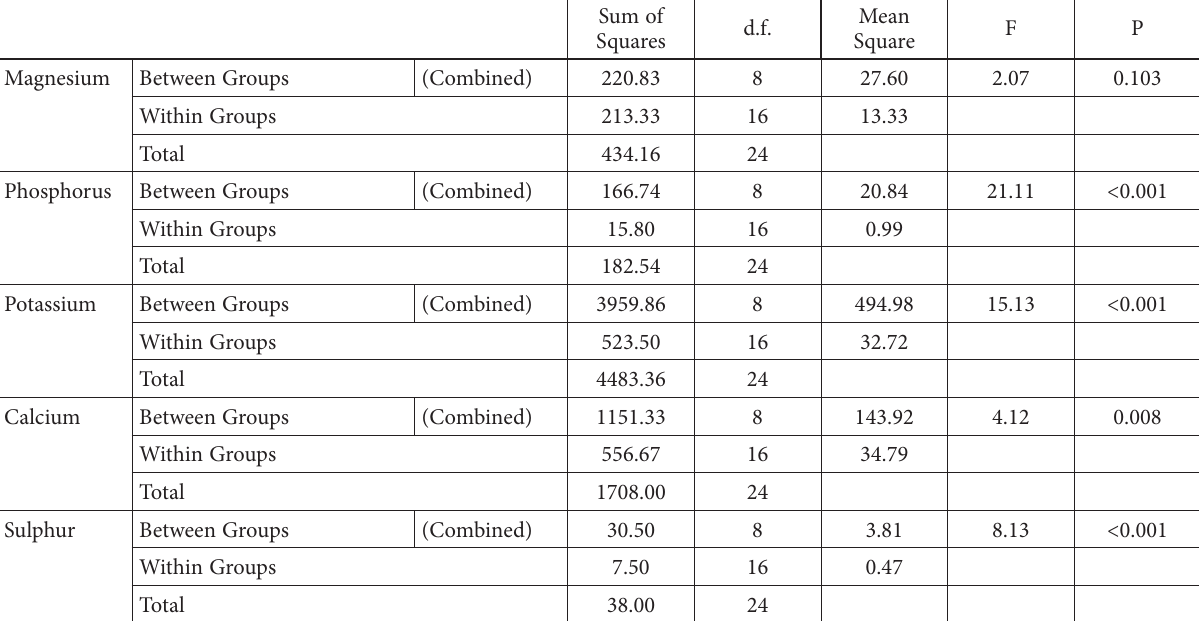
Table 9. ANOVA of the macro-nutrient data